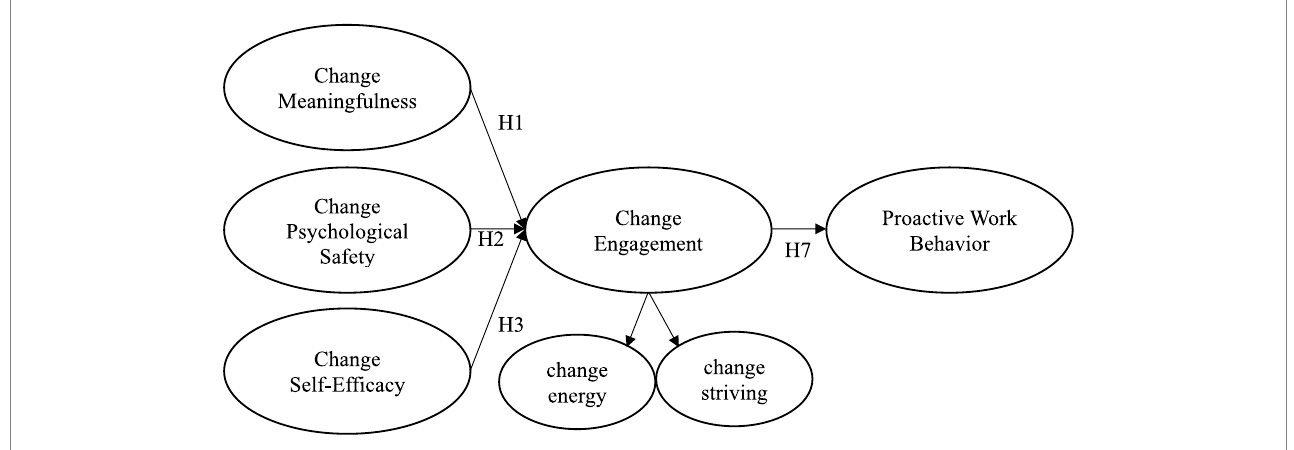
FIGURE 1 Proposed model. H2, H4, and H6 indirect effects not modeled for ease of